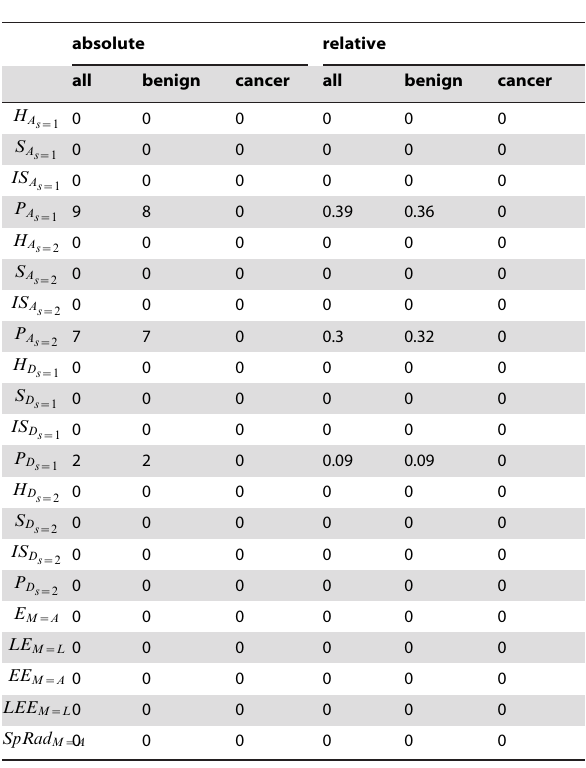
Table 4. ndV-values for the structural biomarkers (eigenvalue and entropy-based measures) for prostate cancer networks and the corresponding subgroups (benign/cancer) for [50].